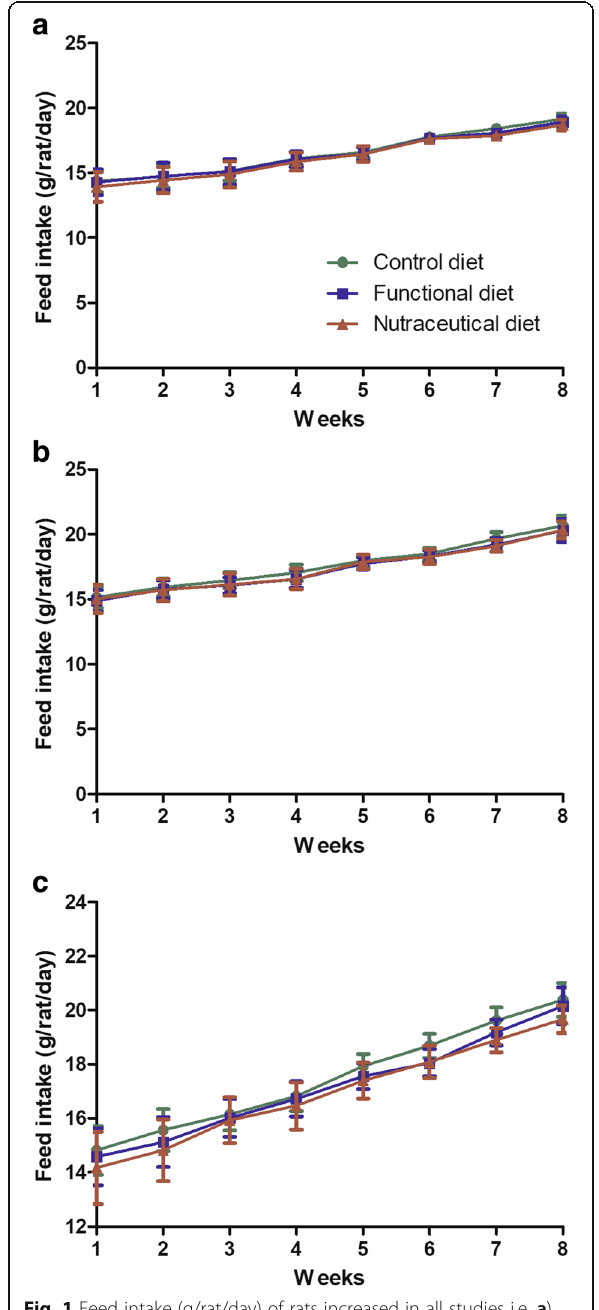
Fig. 2 Drink intake (mL/rat/day) of rats increased in all studies i.e. a ) Normal rats, b ) hyperglycemic rats, c ) hypercholestrolemic rats, from 1st to 8th week. Three type of diets were provided in each study; fluid extraction